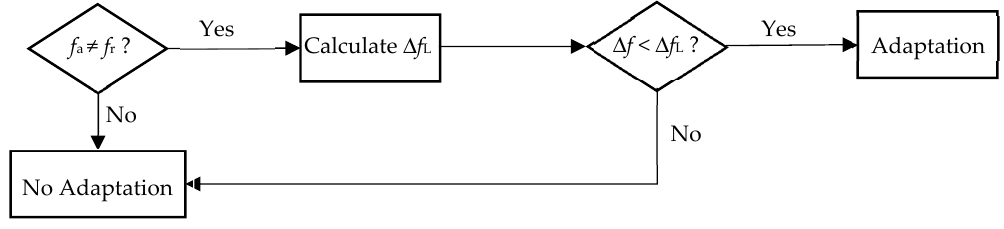
Figure 4. The decision algorithm for a single adaptation step.